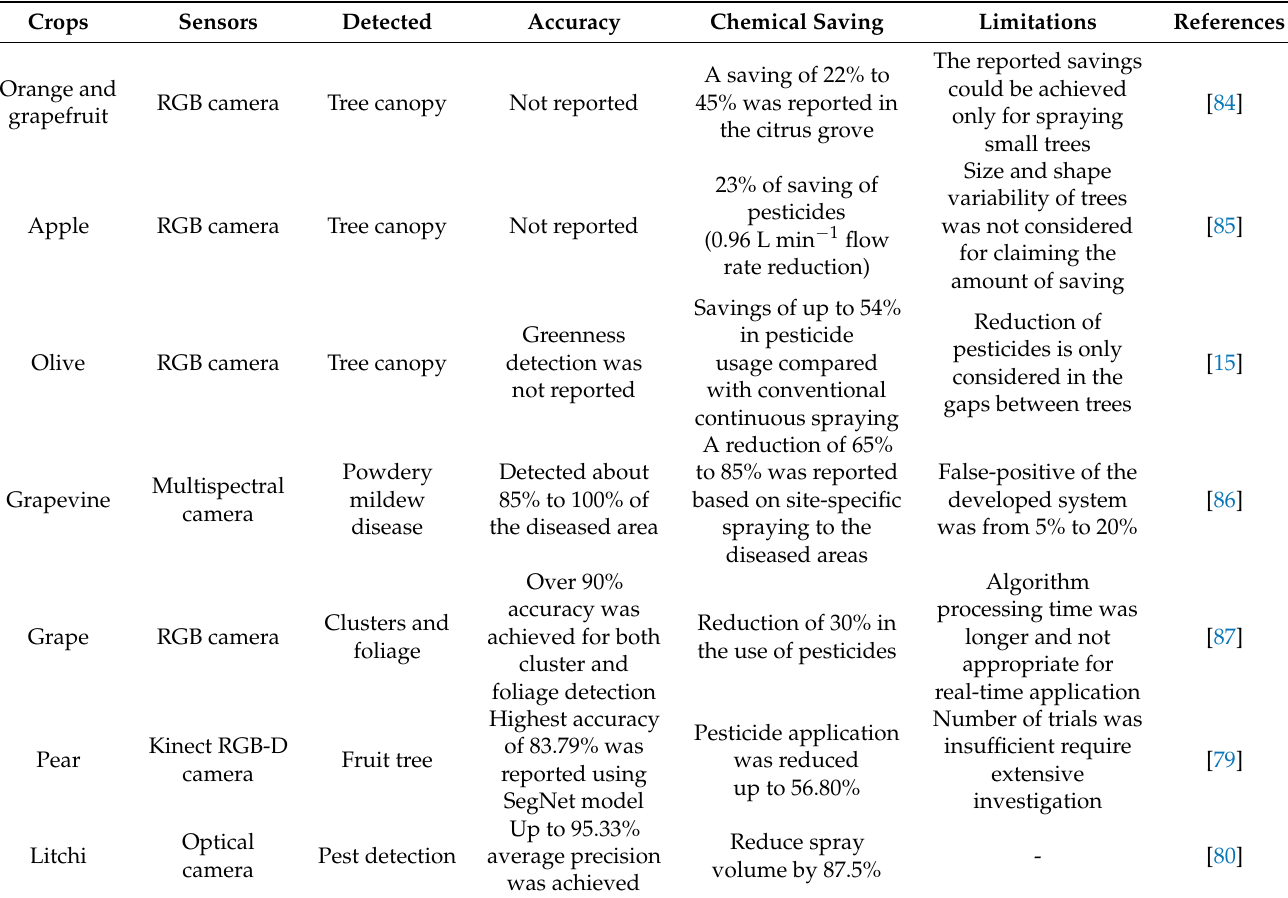
Table 3. Summary of camera sensor used in precision spraying in